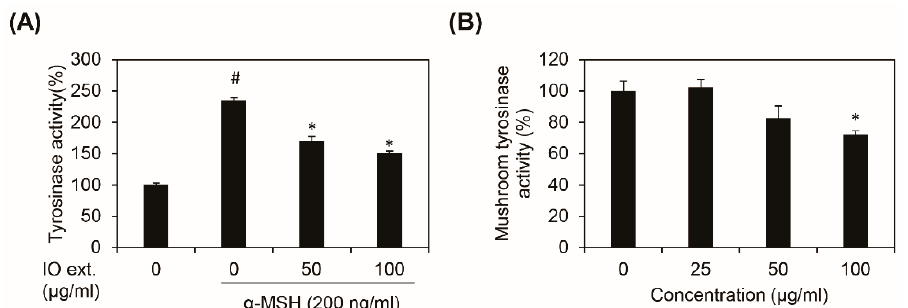
Figure 3. Effects of Inonotus obliquus extract on tyrosinase activity. The Inonotus obliquus extract decreased the tyrosinase activity in the B16F10 mouse melanoma cells. ( A ) Intracellular tyrosinase activity; ( B ) mushroom tyrosinase activity. After adding L-DOPA as a substrate, the mixture was incubated. The amount of generated dopachrome was determined by evaluating the absorbance at 450 nm. The tyrosinase and mushroom tyrosinase activity are shown as a percentage of the control value. All the data values were obtained from the average of three independent experiments ± SD (standard deviation). #: p < 0.05 compared with the non-treated B16F10 cells; *: p < 0.05 compared with the α -MSH-treated B16F10 cells; IO ext.: Inonotus obliquus extracts; and α -MSH: alpha-melanocyte-stimulating hormone.